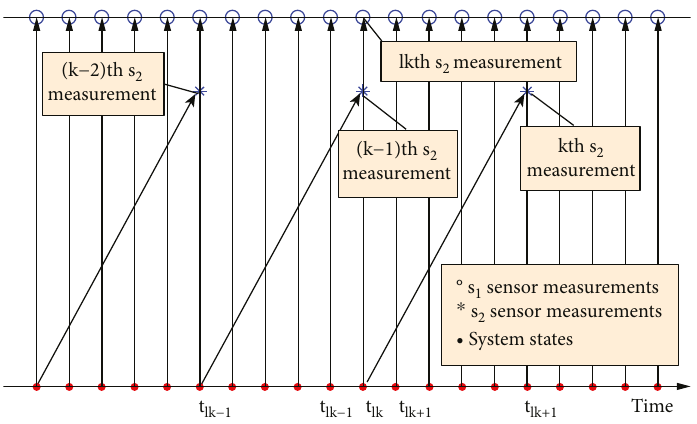
Figure 1: The asynchronous measurement schematic diagram between di ff erent sampling